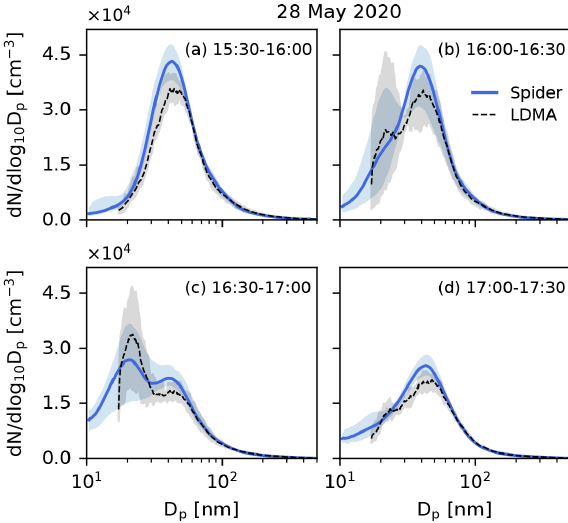
Figure 7. Evolution of the size distribution in the afternoon of 28 May 2020, as measured by the Spider and LDMA systems. Lines represent the mean of size distributions measured over a period of 30min. Shaded areas demonstrate the variation of the size distribu- tion over the averaging period, indicating maximum and minimum values.